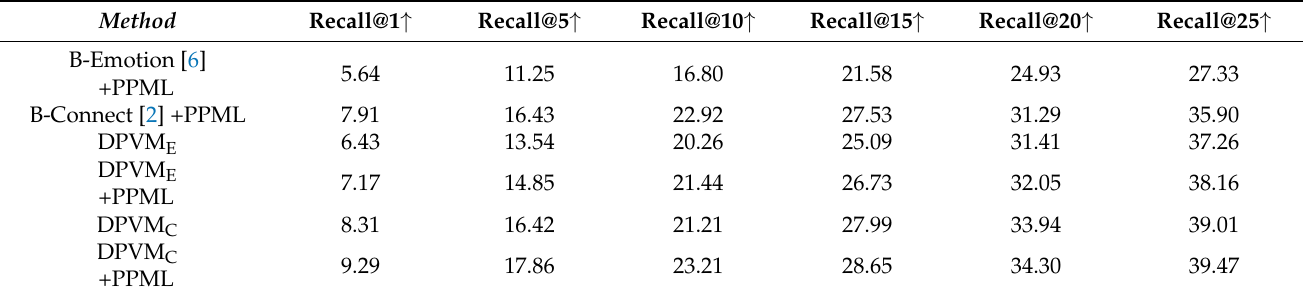
Table 3. Video to music retrieval results on